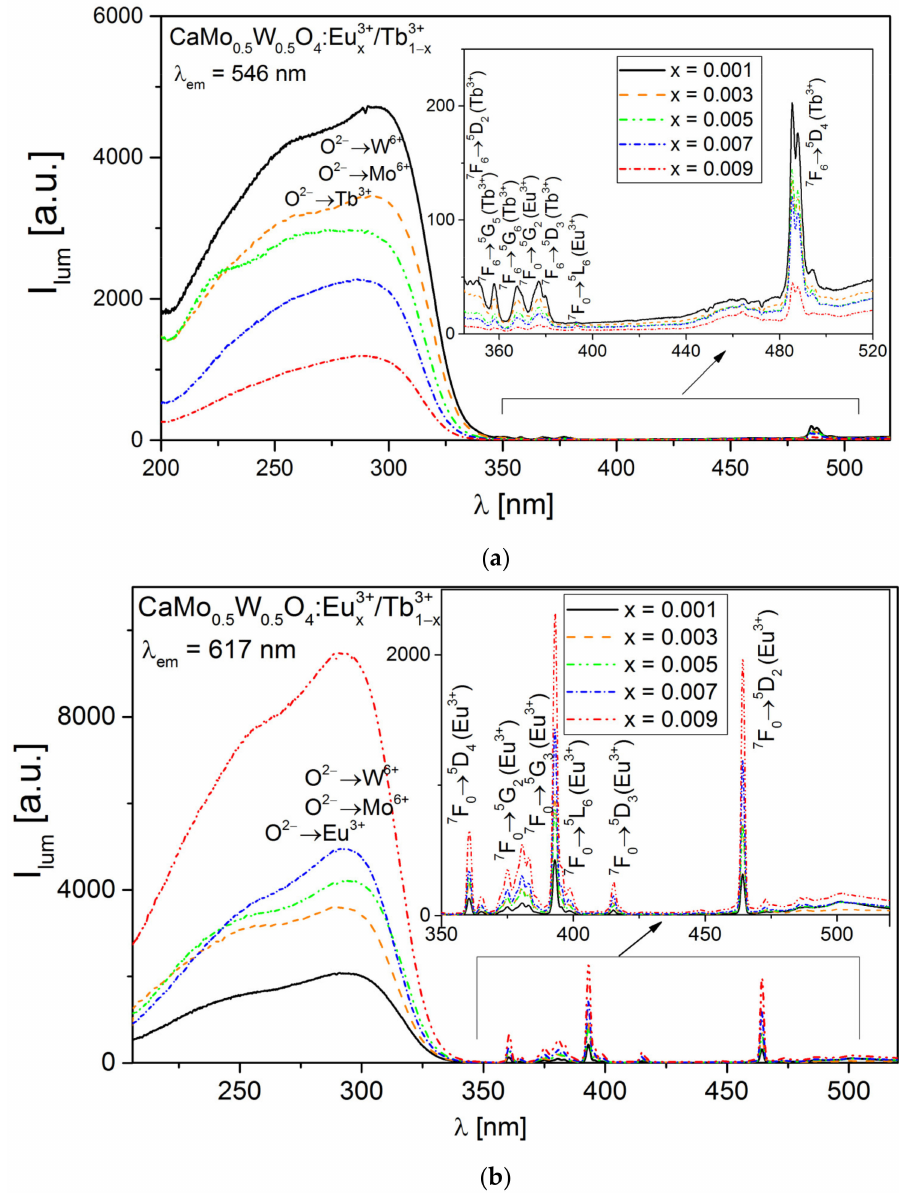
Figure 3. Excitation spectra of CaMo 0.5 W 0.5 O 4 :Eu 3+ x /Tb 3+ 1 − x phosphors monitored at a wavelength of ( a ) λ em = 546 nm and ( b ) λ em = 617 nm. The inserts magnify the bands in the range from 350 to 520